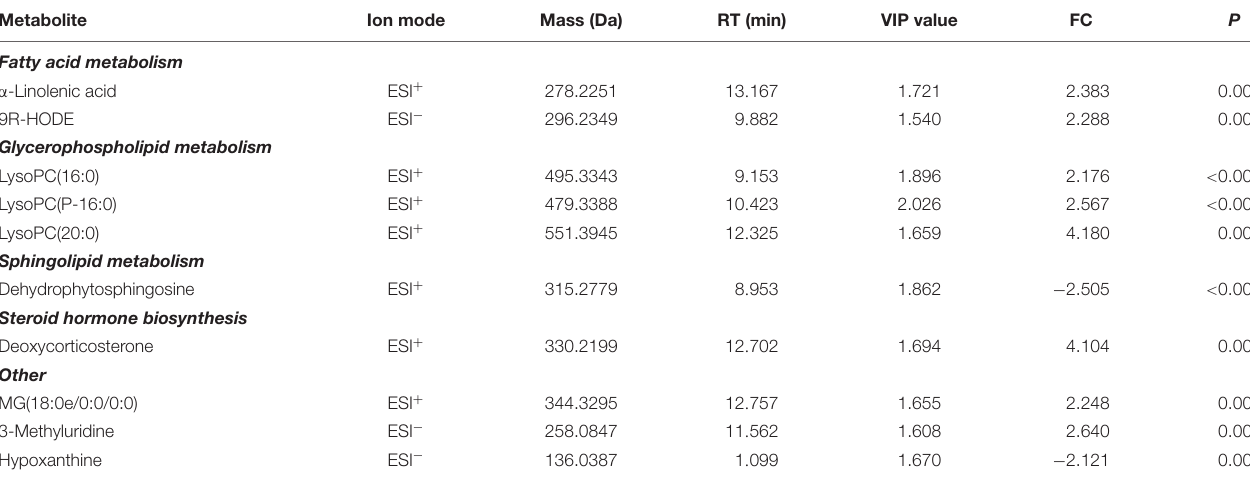
TABLE 1 | Key metabolite differences of respiratory tree tissues in A. japonicus between the non-breeding stage and the breeding stage. Metabolite Ion mode Mass